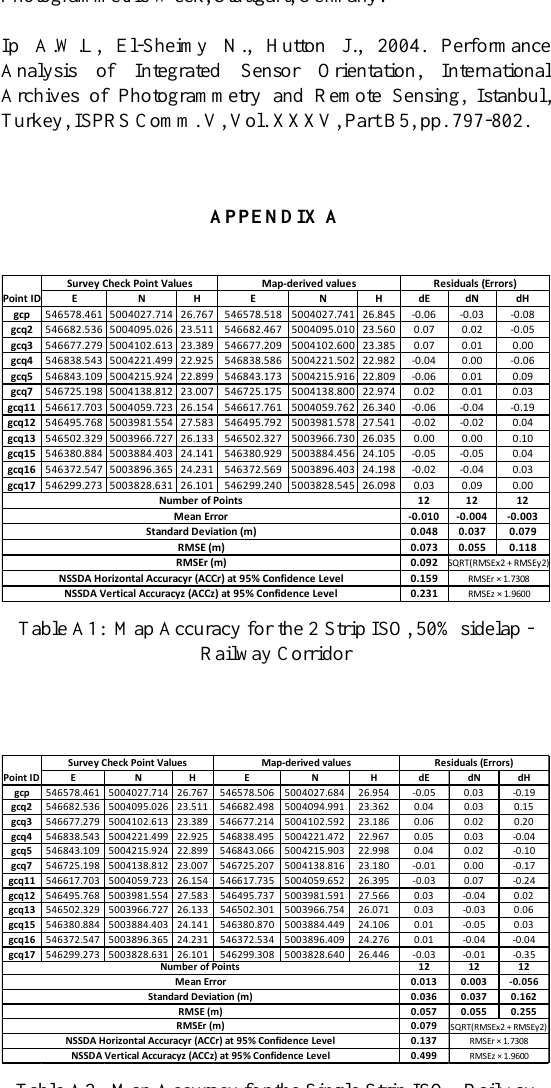
Table 5: 2 Strip Accuracy Results, ISO, 30% sidelap – Fryer Dam